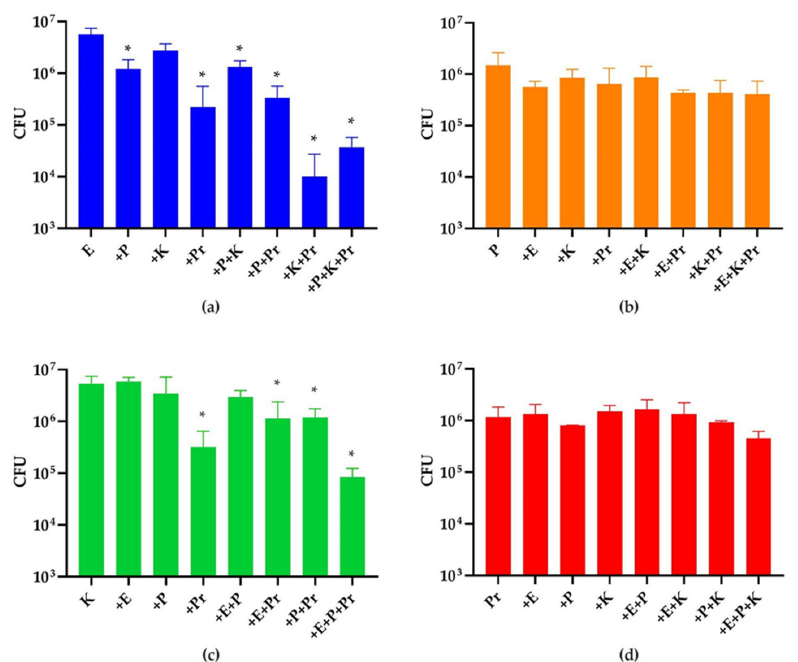
Figure 2. Species abundance in 20 h mono- and multispecies biofilms. CFUs of ( a ) E. coli (E), ( b ) P. aeruginosa (P), ( c ) K. oxytoca (K) and ( d ) P. mirabilis (Pr) were quantified. The first left column of each panel shows the CFUs of each species in monospecies biofilms. The rest of the columns show CFUs of each strain in multispecies biofilm of different combinations as indicated in x axis. The * indicates a significant difference ( p < 0.05) in the strain’s CFUs in such a combination compared to that in its monospecies biofilm. The experiment was performed in three biological replicates.